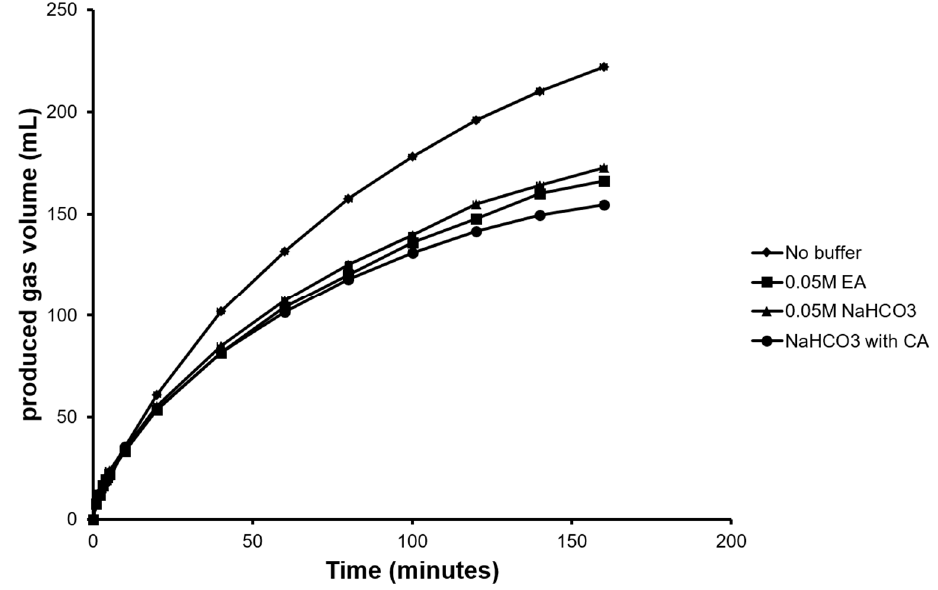
Figure 2. Total gas produced (H 2 + CO 2 ) from simultaneous FA decomposition and in-situ CO 2 capture using different buffers.